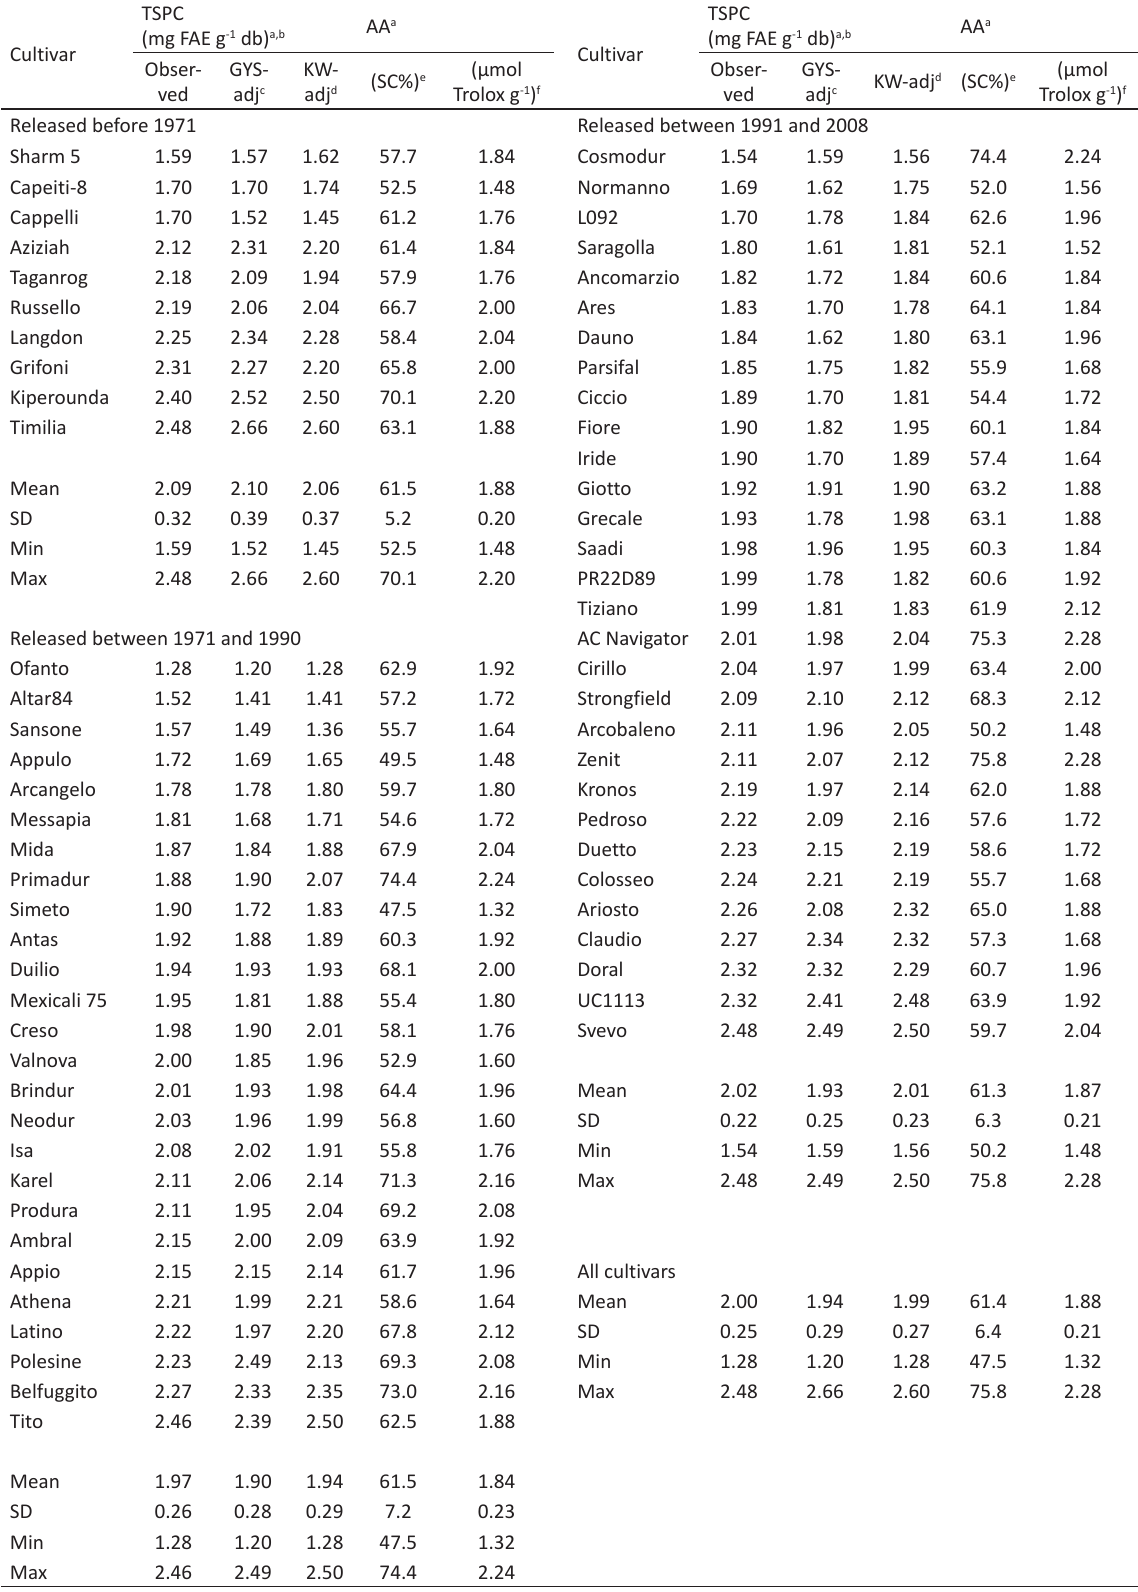
Table 1. Total soluble phenolic compounds (TSPC) and antioxidant activity (AA) of 65 durum cultivars and one breeding line (L092) included in a tetraploid wheat collection grown at Valenzano (Bari, Italy) in 2010. Samples were grouped according to the year of release.